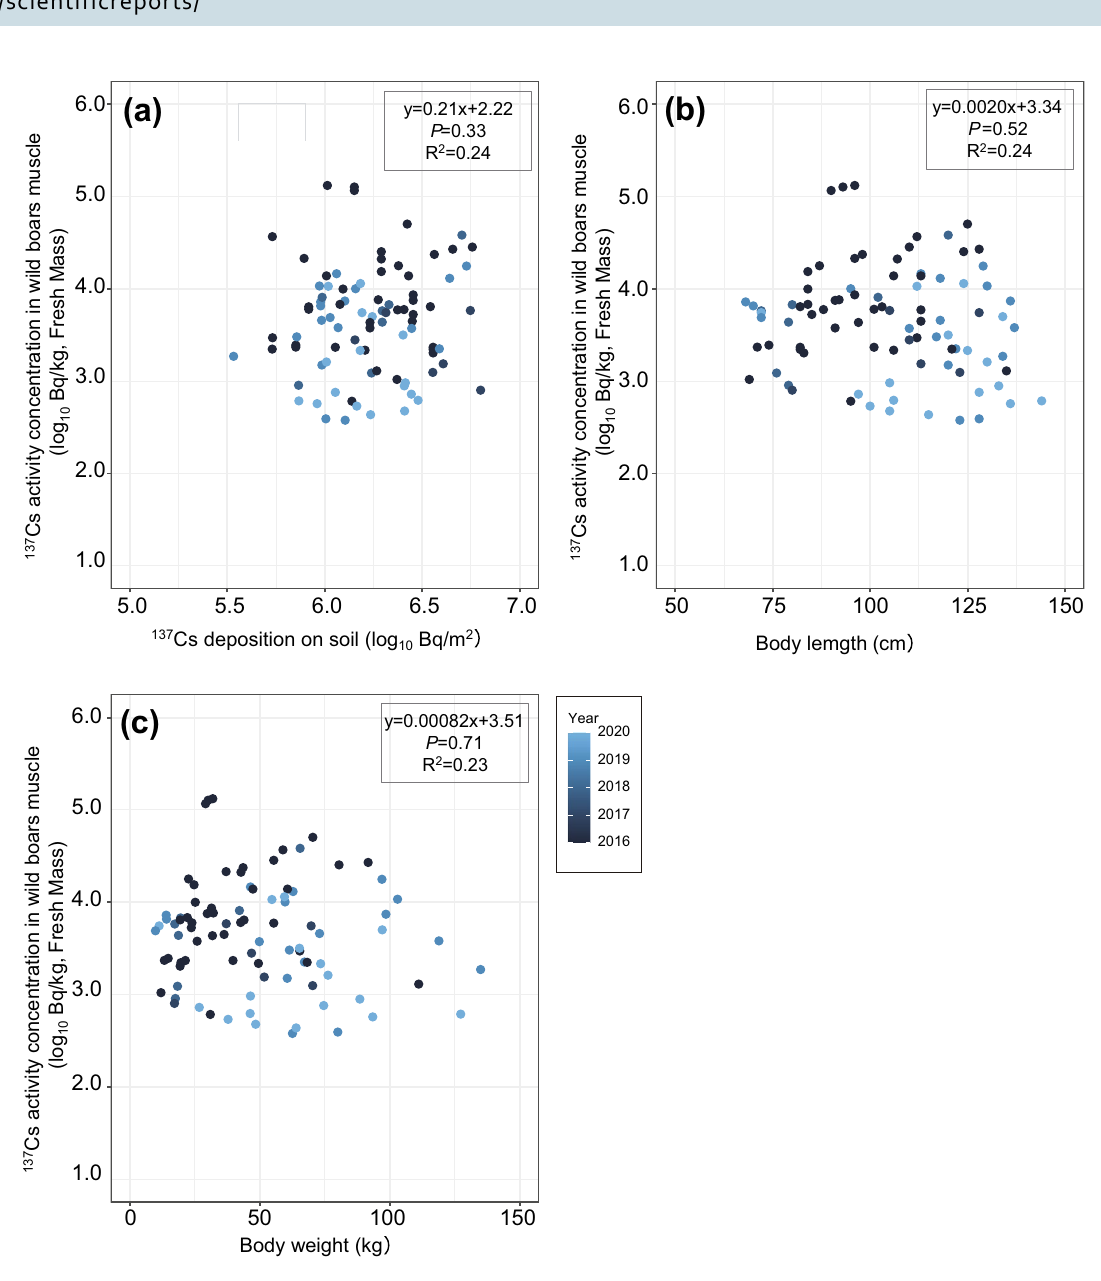
Figure 5. Relationships between 137 Cs activity concentration of wild boar muscle samples collected in the high- activity-concentration season (December to March) from inside the difficult-to-return zone (DRZ) and ( a ) 137 Cs deposition on soil (log 10 Bq/m 2 ), ( b ) body length (cm), and ( c ) body weight (kg). Results of the regression analysis are based on mixed linear models using years as random variables and the adjusted coefficient of determination (R 2 ) are shown in the